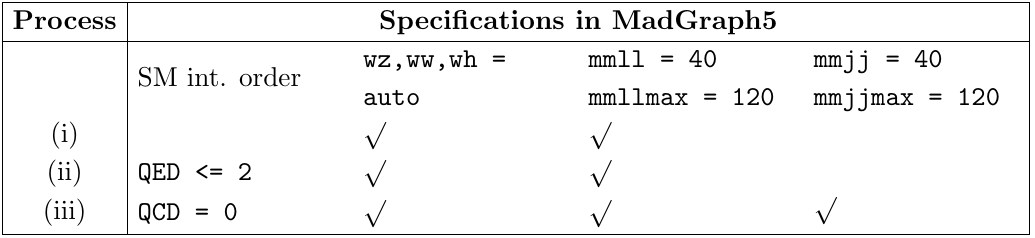
Table 8 . Details of the options speci(cid:12)ed in MadGraph5 for the generation of events for each of the processes considered (see text for